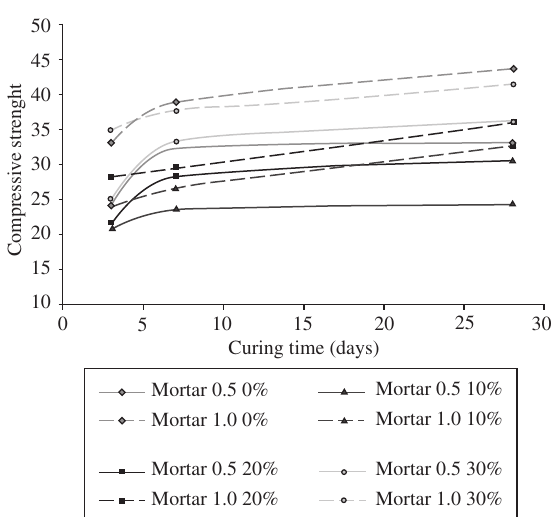
Figure 6. Tensile strength under diametral compression of magnesium phos- phate cement mortar as a function of sand and grinding dust